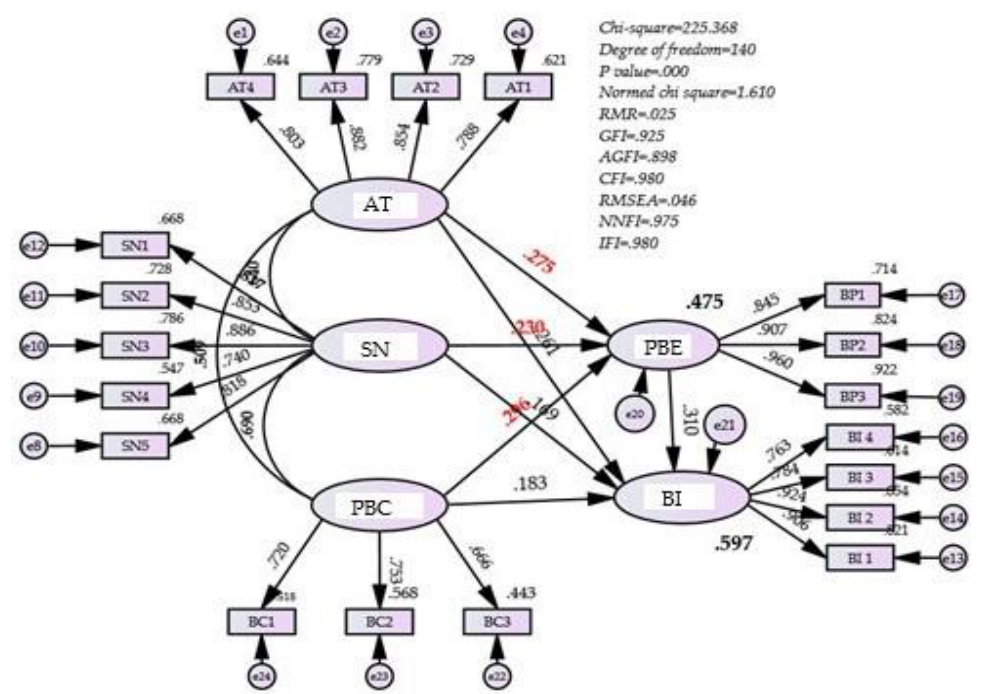
Figure 2. Structural equation model.AT = attitude; SN = subjective norms; PBC = perceived behavioural control; PBE = perceived benefit of vitamin D; BI = supplementation intention; GFI = goodness of fit index; AGFI = adjusted goodness of fit index; CFI = comparative fit index; NNFI = non-normed fit index; IFI = incremental fit index; RMSEA = root mean square error of approximation.